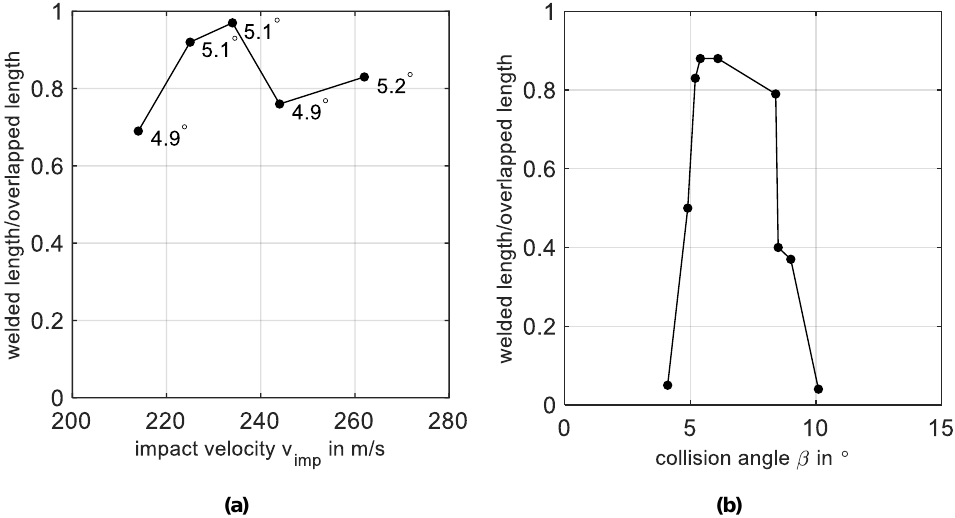
Figure 4. The ratio of welded to overlapped length of the samples for different impact velocities at a constant collision angle of approximately β = 5.0° ( a ) and for different collision angles at a constant impact velocity of v imp = 262ms − 1 ( b